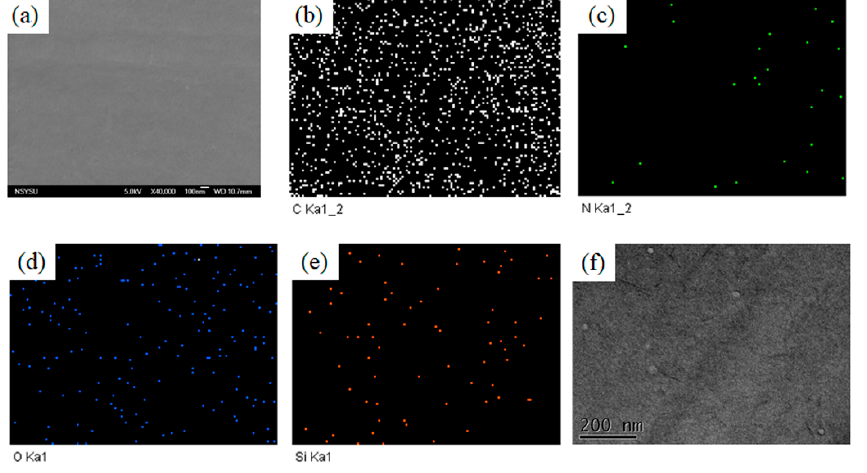
Figure 7. ( a ) SEM, ( b ) C, ( c ) N, ( d ) O, and ( e ) Si-mapping and ( f ) TEM image of epoxy/DDSQ-BMI = 3/1 after thermal